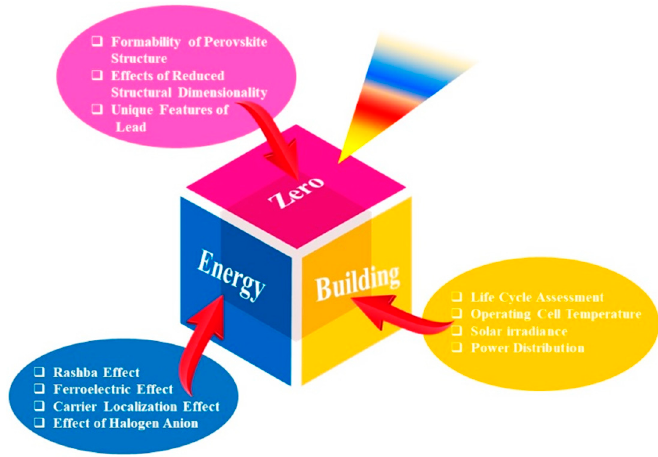
Figure 10. Scheme of the PSC-integrated BIPV modelling study for zero-energy building development.